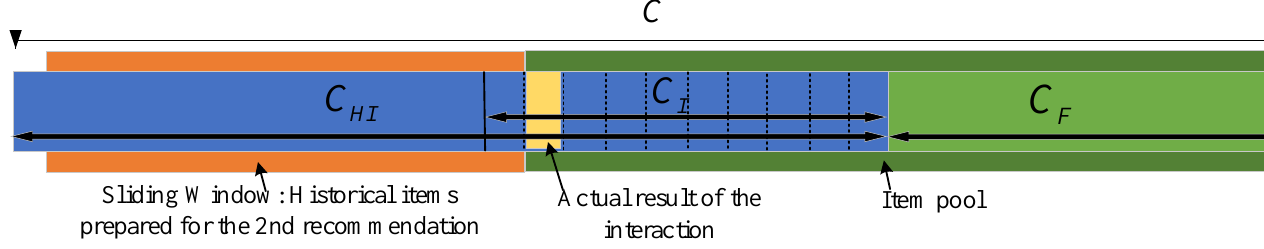
Figure 3. The data set division of the